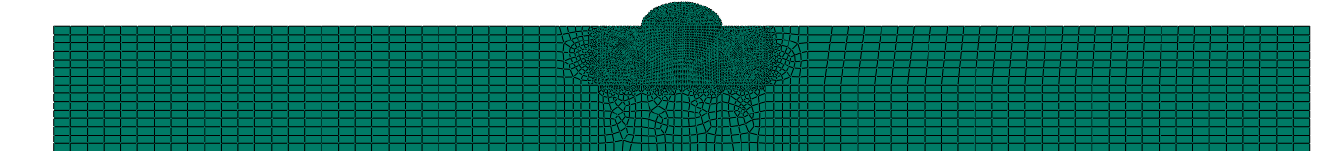
Figure 7. Mesh shape by zone.